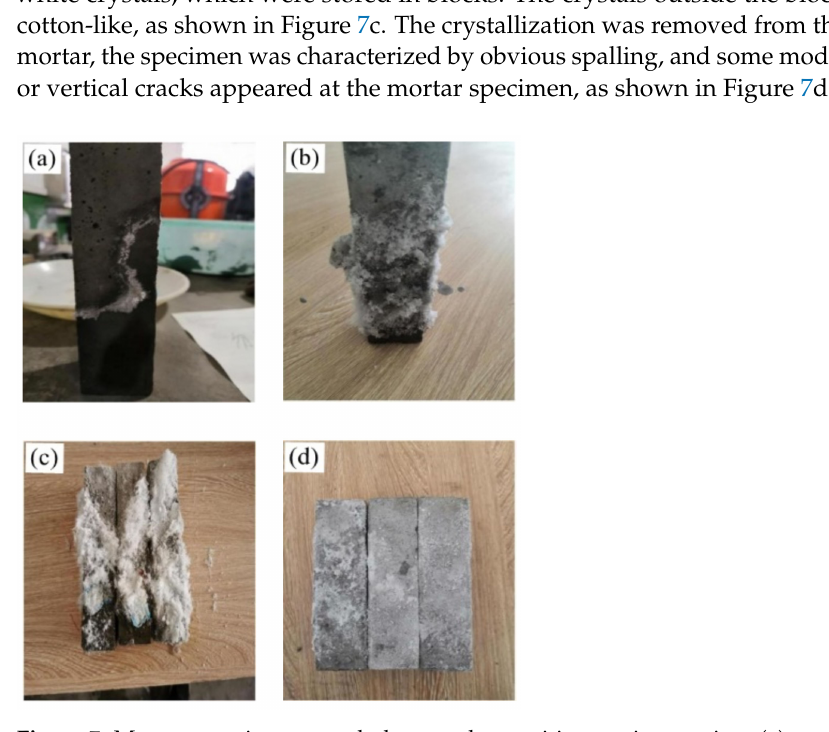
Figure 7. Mortars specimen morphology under semi-immersion erosion. ( a ) one month, ( b ) three months, ( c ) six months, ( d ) removed the